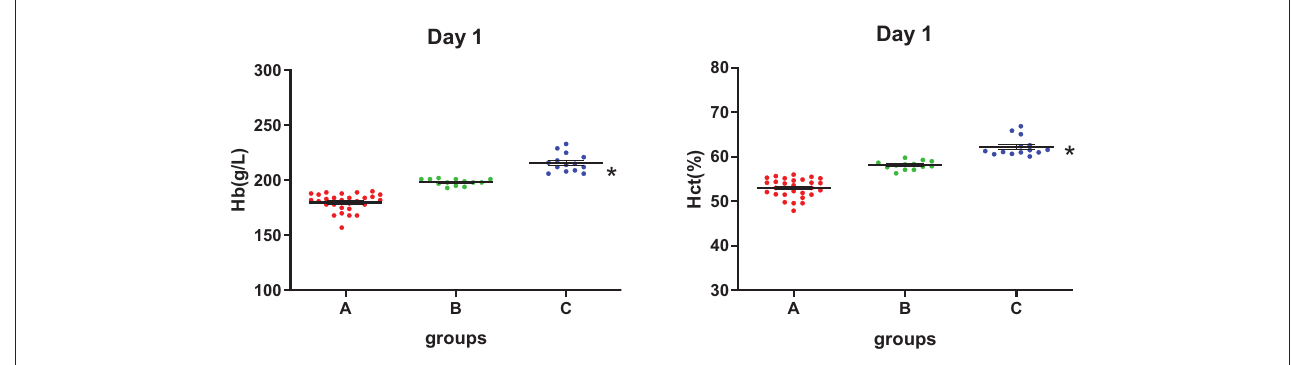
FIGURE1 Hemoglobin concentration ([Hb]) and hematocrit (Hct) level of three groups on day 1. *Analysis of variance (ANOVA), p < 0.05 ( p = 2.13E-9, 2.95E-20) for group C vs. group A.